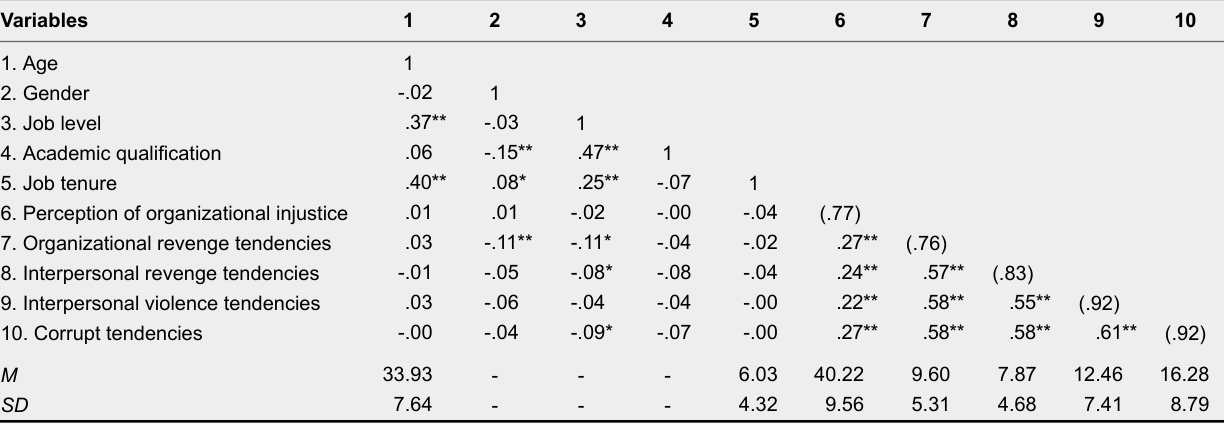
Mean, Standard Deviation, Inter-Variable Correlations, and